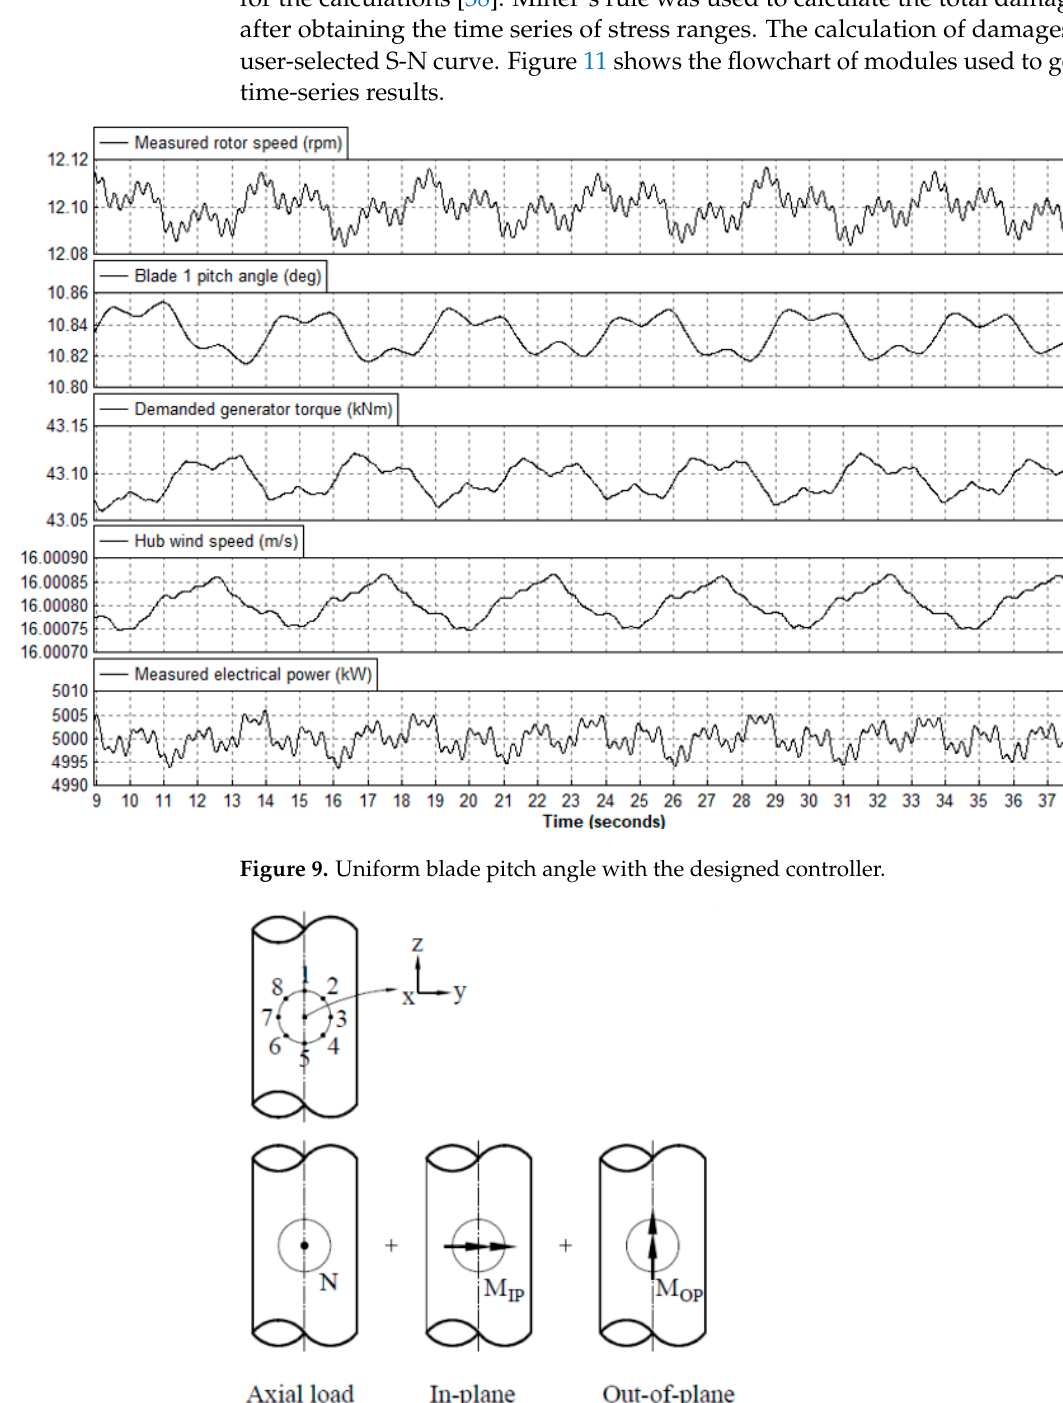
Figure 10. Hotspots of K-joint [44].